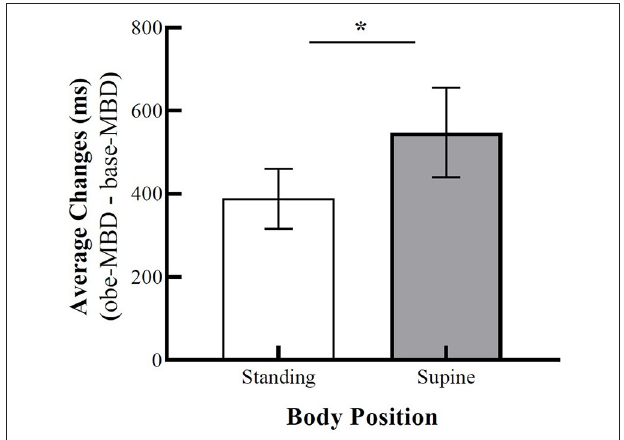
FIGURE 4 | Average scores of the self-report questionnaire. Error bars represent SEM. Asterisk denotes a significance level of p < 0.05.